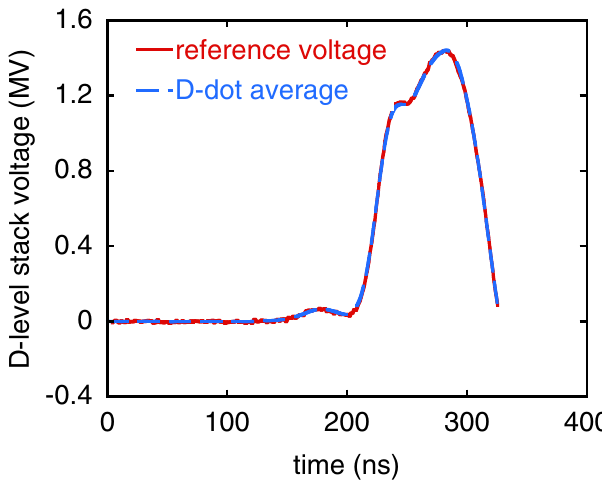
FIG. 11. (Color) Result of an in situ calibration of a differential- output D -dot voltage monitor. The reference voltage is generated using current measurements (made with calibrated B -dot current monitors) and the geometry of the stack-MITL-load system. The normalized standard deviation of the pointwise difference be- tween the two voltage-pulse shapes is less than 1%. The standard deviation is calculated using an expression analogous to Eq. (12).